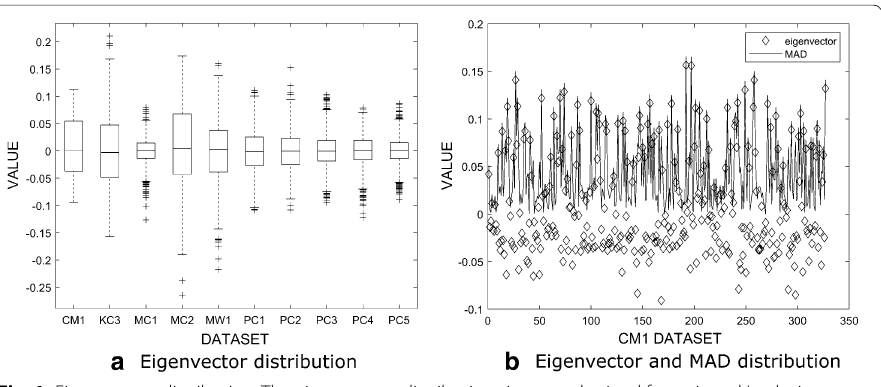
Fig. 1 Eigenvectors distribution. The eigenvectors distributions in a are obtained from signed Laplacian matrix decomposition of all datasets using Eq. 10. These eigenvectors distributions show that almost eigenvectors come with outliers. b shows the example of eigenvector distribution with MAD of CM1